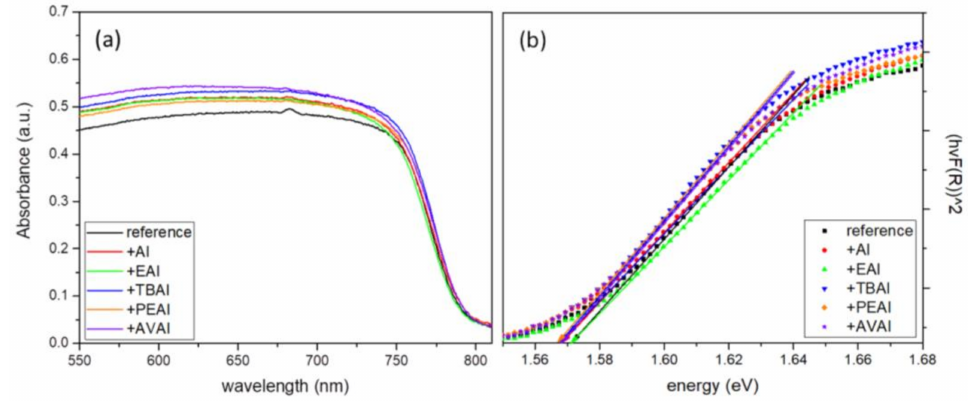
Figure 2. ( a ) UV-vis absorption spectra and ( b ) Tauc plots of the 6 perovskite films under